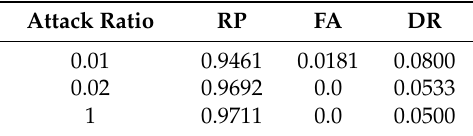
Table 4. Performance of HMM-R at different attack ratios ( α = 1).